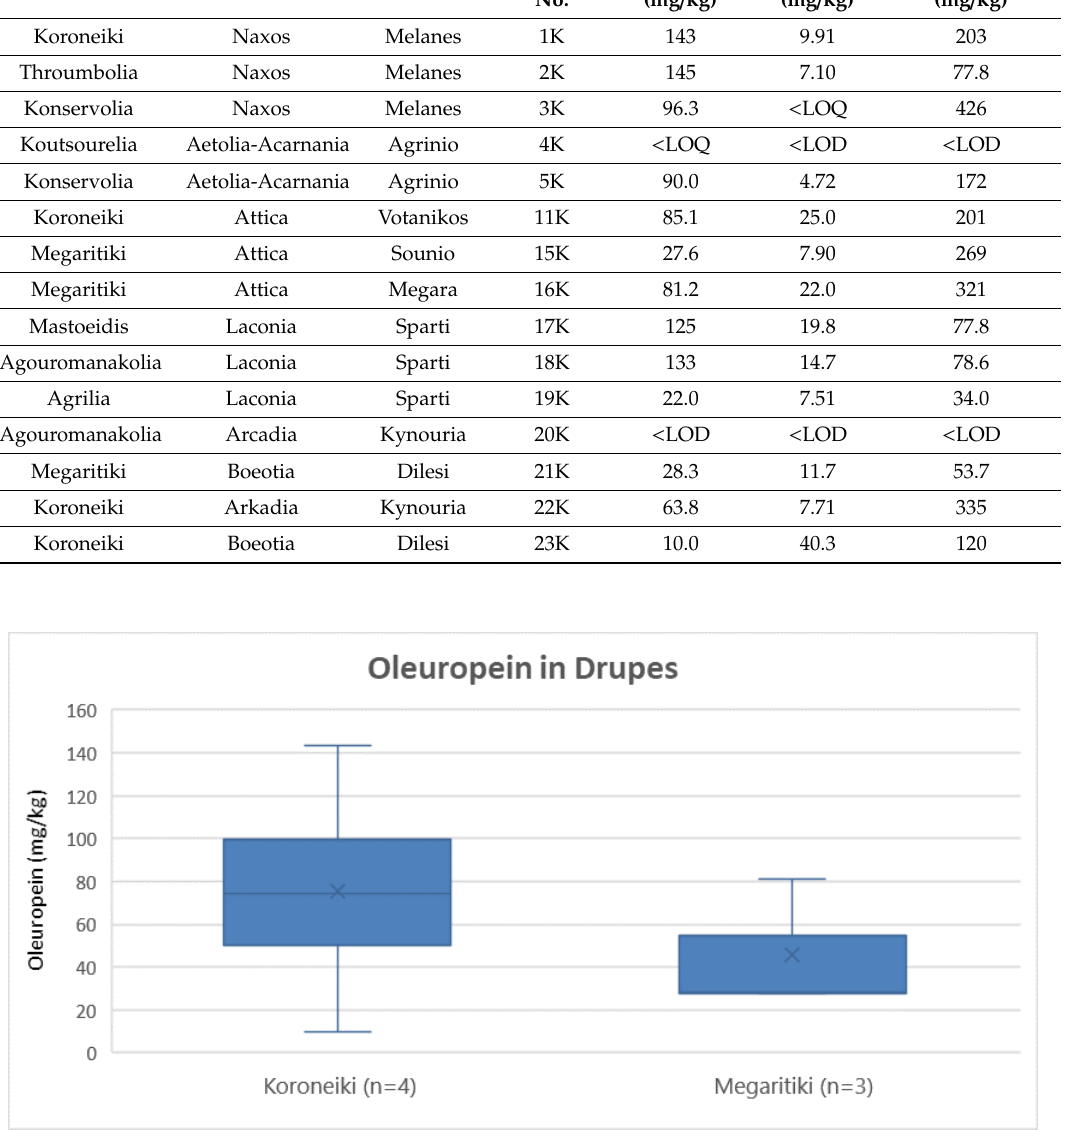
Figure 11. Box and whisker plot for the concentrations of tyrosol between different varieties of drupes. Hydroxytyrosol As shown in Figure 12, hydroxytyrosol concentration was the same on average (215 mg/Kg) for both Koroneiki and Megaritiki. ANOVA verified that there was no statistically significant difference between the two varieties ( p = 1.0).